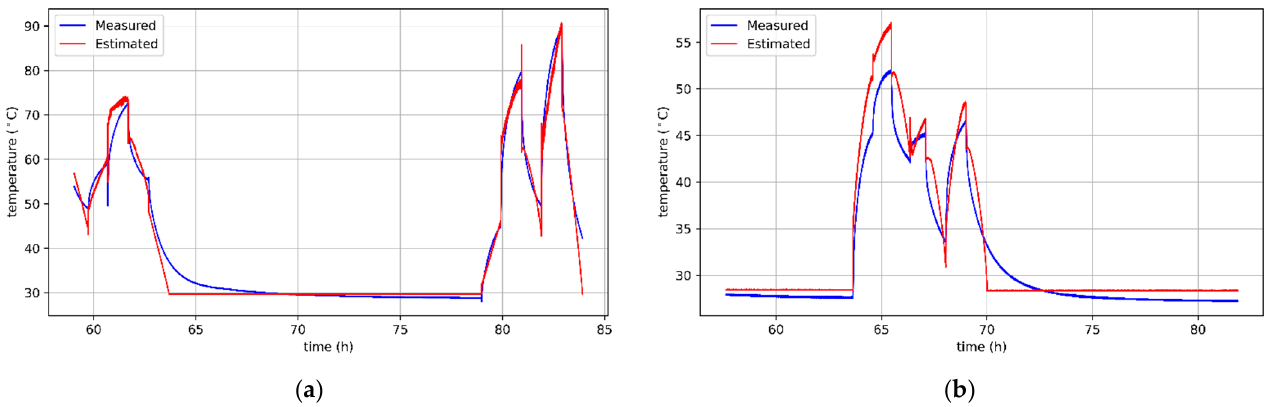
Figure 8. Results of sensorless temperature estimation for the motor: ( a ) without cooling, obtained with ElaticNet regressor; ( b ) with a cooling fan, obtained with SGD regressor.